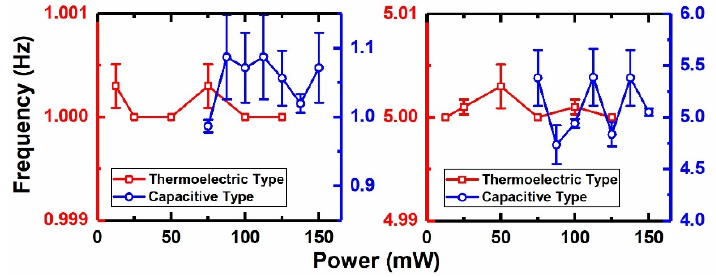
Figure 10. Different frequency’s test errors versus different input power.